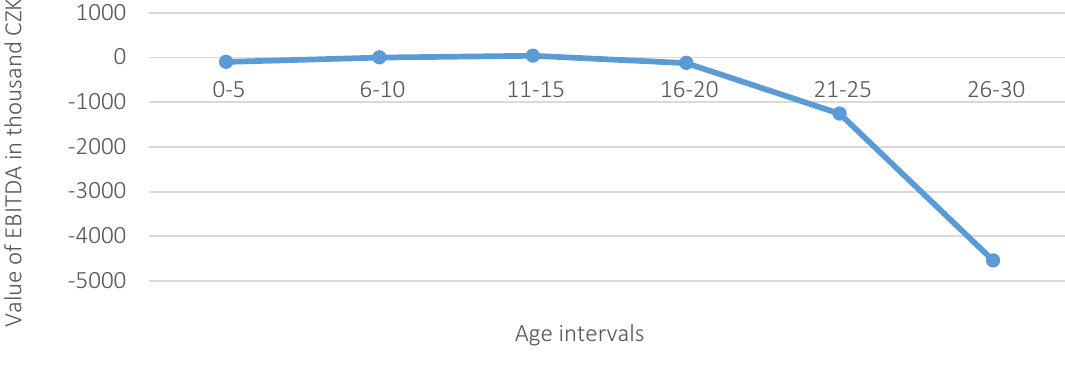
Figure 4. Value of enterprise EBITDA (measured in thousand CZK)